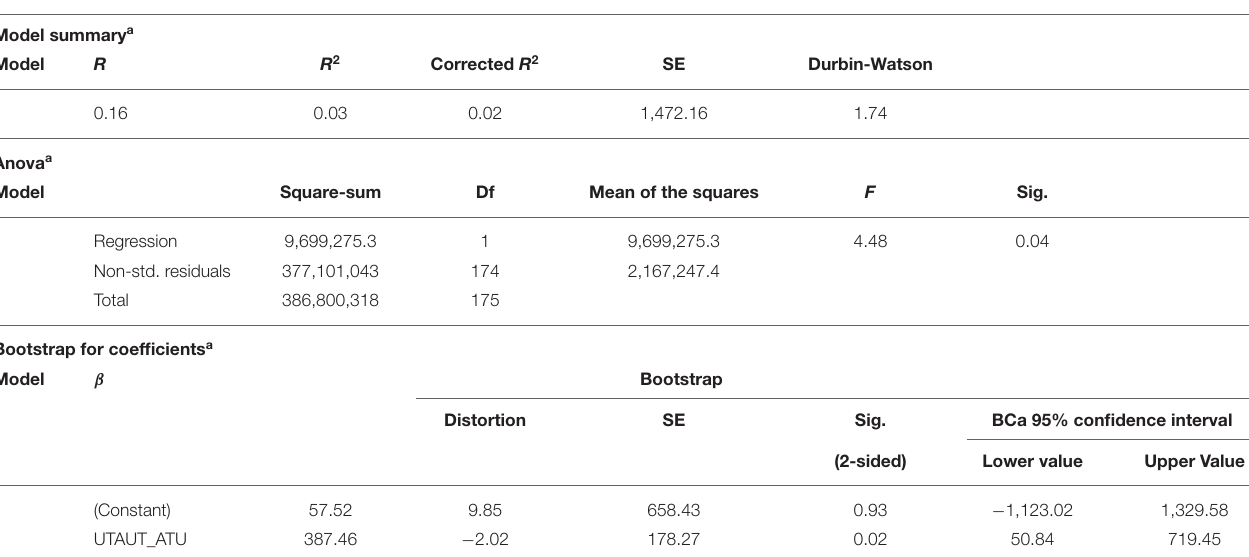
TABLE 7 | Influence of attitude to use on willingness to